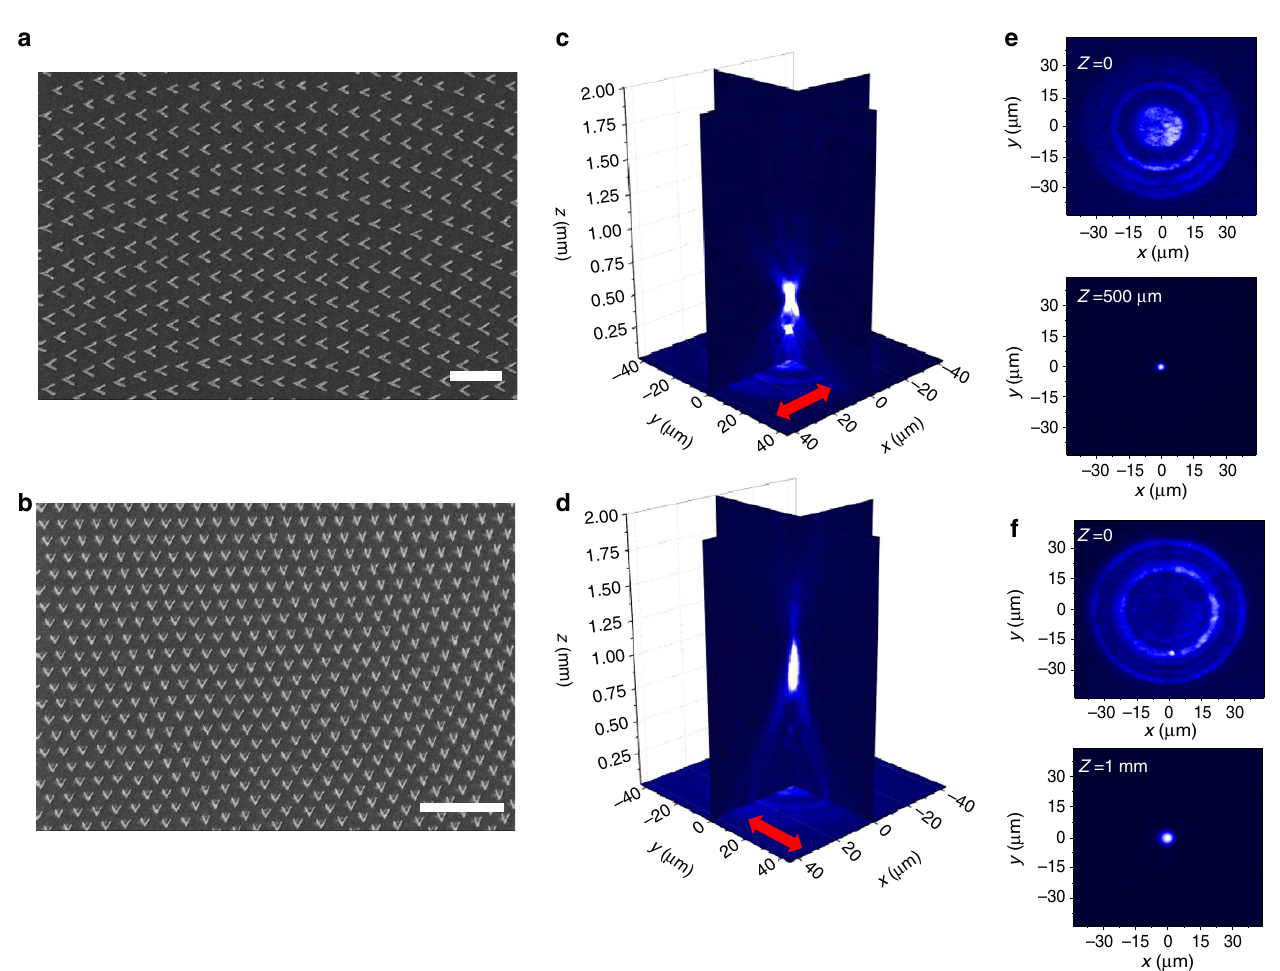
Figure 5 | A polarization-controlled nonlinear lens. Scanning electron microscopy (SEM) images of the first ( a ) and the second ( b ) layers of a nonlinear lens made by a 3D nonlinear metamaterial. The scale bars are 1 and 2 m m in a and b , respectively. Microscopic images of the third harmonic signal away for the surface of the metamaterial device for a horizontally ( c ) or vertically ( d ) polarized fundamental beam. The first active layer ( a ) focuses the TH radiation around the focal point z ¼ 500 m m ( c ), while the second layer focus the light at z ¼ 1mm ( d ). Microscopic images at z ¼ 0 and z ¼ 500 m m for horizontal polarization ( e ) and z ¼ 0 and at z ¼ 1mm for vertical polarization ( f ). The Gaussian RMS widths at z ¼ 500 m m and z ¼ 1mm are s ¼ 1.2 and 2.2 m m, respectively, close to the theoretical diffraction limited values s ¼ 1.1 and 2.2 m